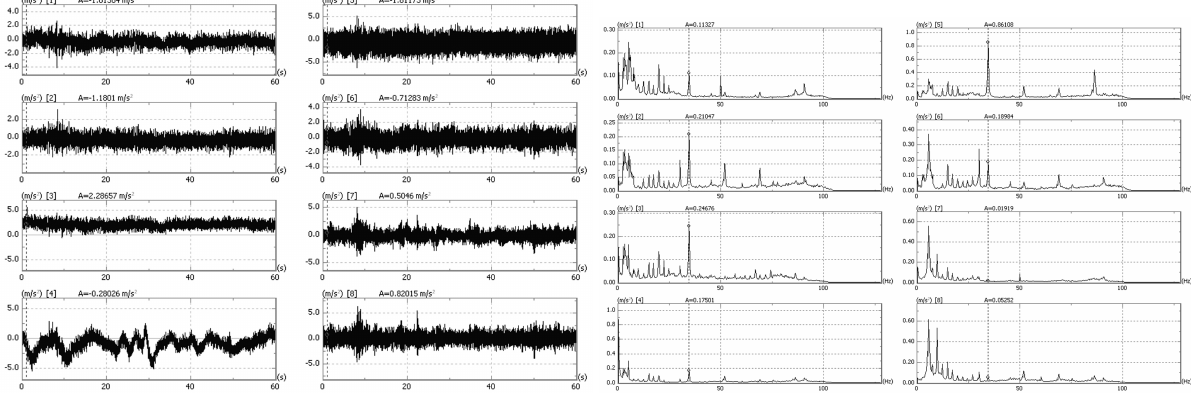
Fig. 8 Waveform and spectrum of each measuring point at a speed of 30